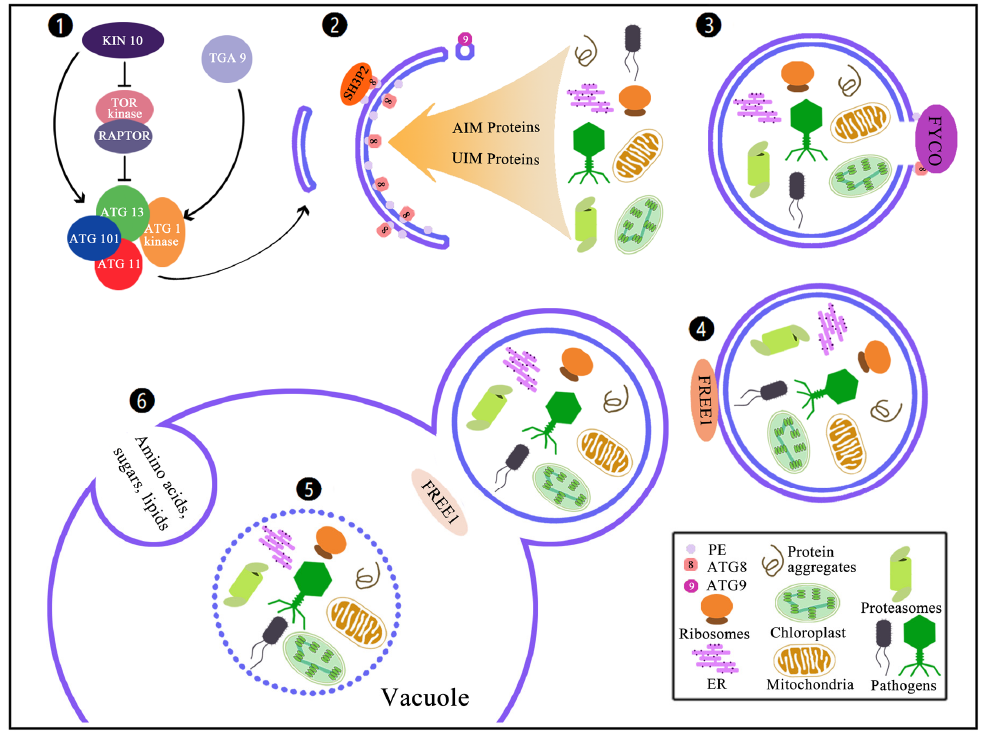
Figure 1. The molecular route of autophagy. ( 1 ) Induction of macroautophagy is regulated upon favorable and unfavorable conditions: The TOR and RAPTOR kinase complex represses the ATG13-ATG1-ATG101-ATG11 complex to regulate the macroautophagy induction negatively, whereas the KIN10 suppresses the TOR-RAPTOR activity in parallel with the positive role of TGA9 to modulate autophagy induction. ( 2 ) ATG9 regulates the delivery of lipids to the developing phagophore, while the SH3P2 interacts with ATG8 to decorate autophagosomes, and the AIM or UIM proteins facilitate the transportation of damaged organelles and invasive pathogens to the autophagosomes. ( 3 ) With the help of FYVE and coiled-coil domain-containing (FYCO) proteins, the autophagosome is tethered to the microtubule transport machinery. ( 4 ) Fusion of the autophagosomes with the tonoplast is mediated by FYVE-DOMAIN PROTEIN REQUIRED FOR ENDOSOMAL SORTING 1 (FREE1) and other proteins, and then releases autophagic bodies into the vacuole. ( 5 ) The autophagic bodies are subsequently degraded by vacuolar hydrolases. ( 6 ) The microautophagy is preceded by invagination of the tonoplast to engulf portions of the cytosolic constituents directly into autophagic bodies within the vacuole, like amino acids, sugars and lipids. Both pathways are dedicated to a cytoplasm-to-vacuole route and eventually lead to the storage and / or recycling of